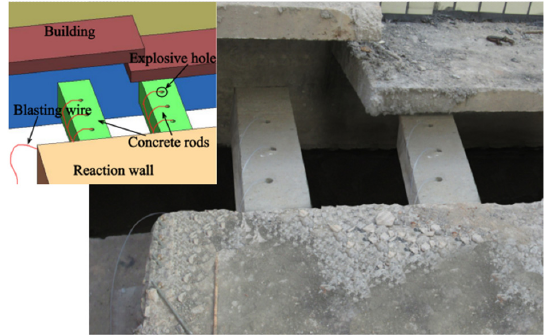
Figure 15. Schematic diagram of hydraulic jack.